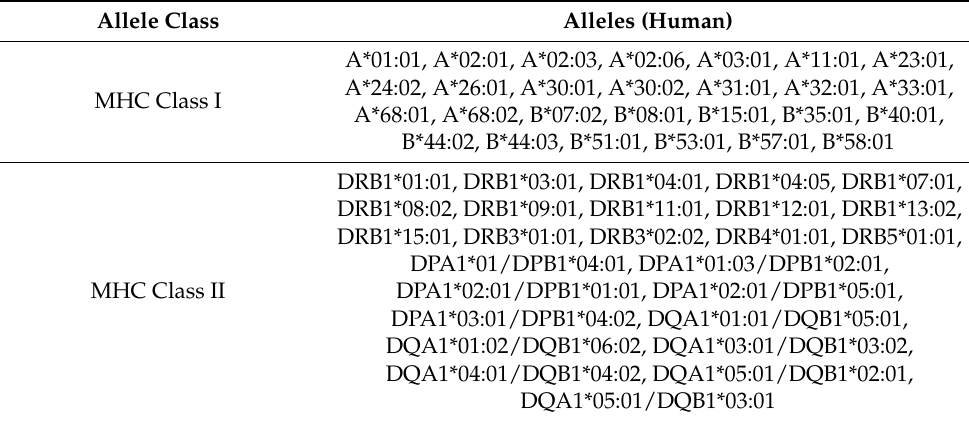
Table 4. Alleles used in the TepiTool predictions. Allele